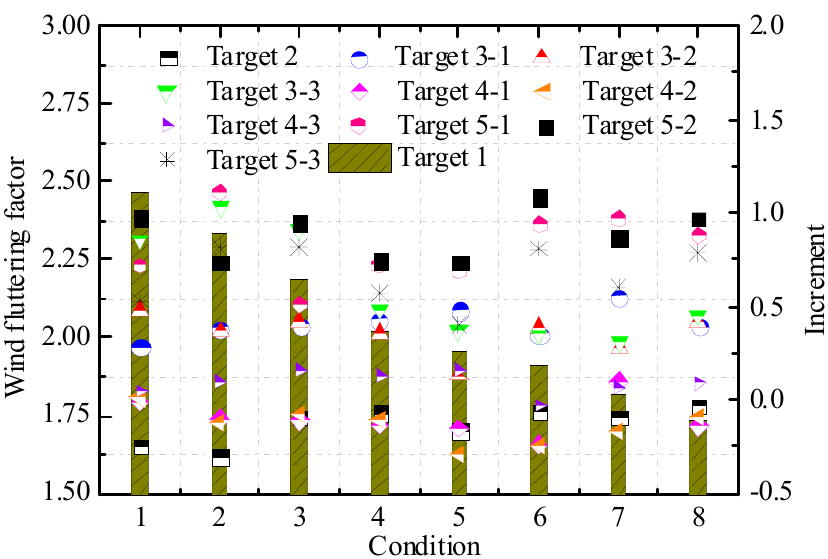
Figure 10. Comparison of wind vibration coefficient under the five equivalent targets between eight working conditions.